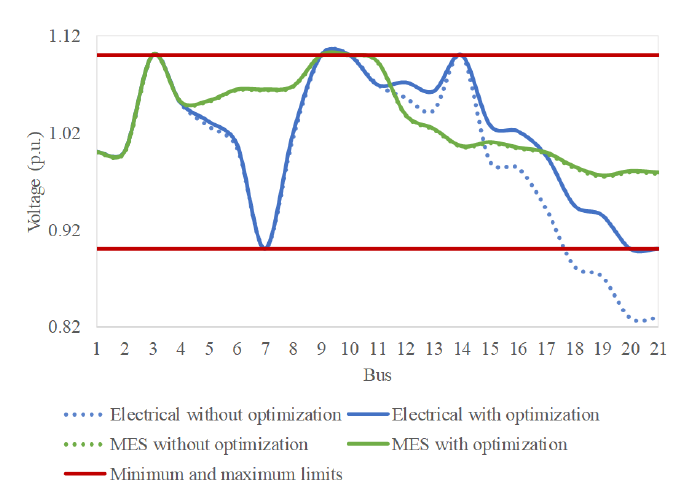
Figure 8. Voltages in the buses at 6 h (peak hour).